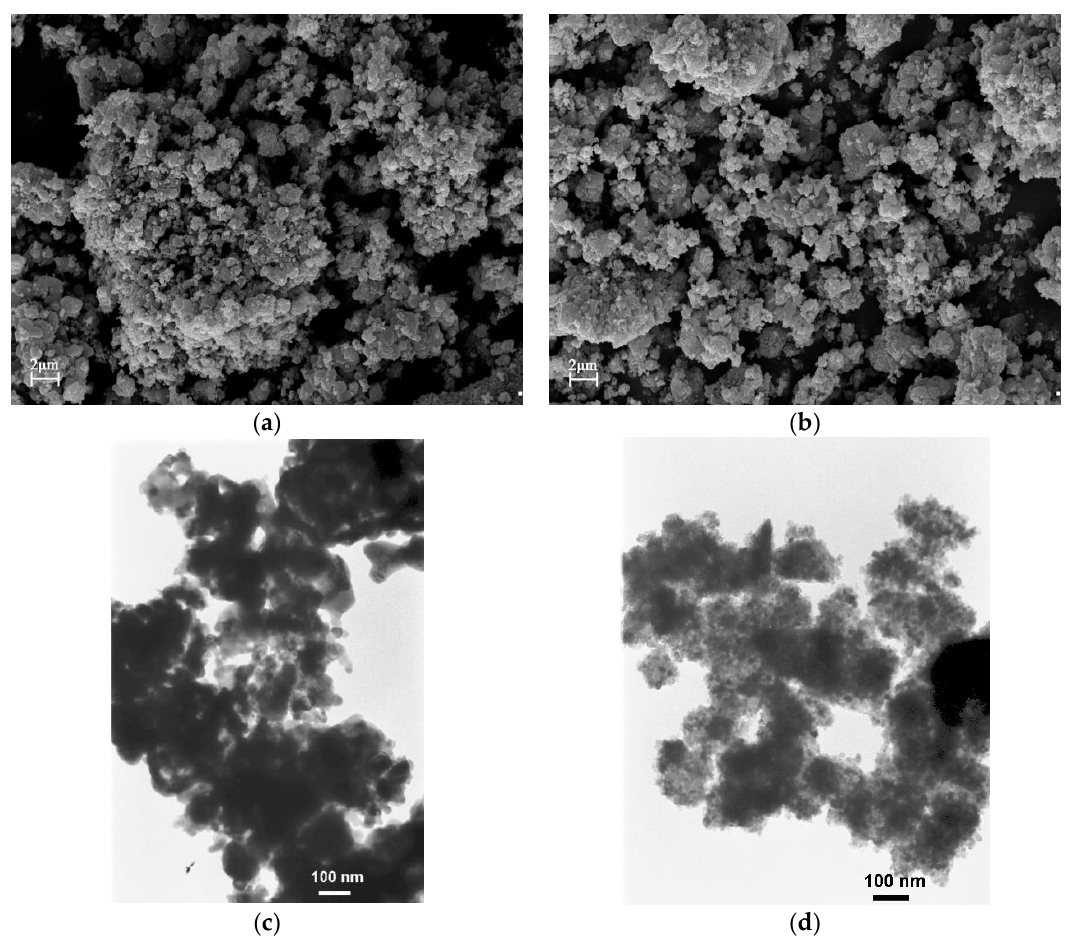
Figure 1. Scanning electron microscope (SEM) and transmission electron microscope (TEM) photos of: ( a , c ) pure TiO 2 -ZrO 2 and ( b , d ) pure TiO 2 -ZrO 2 -SiO 2 oxide materials.